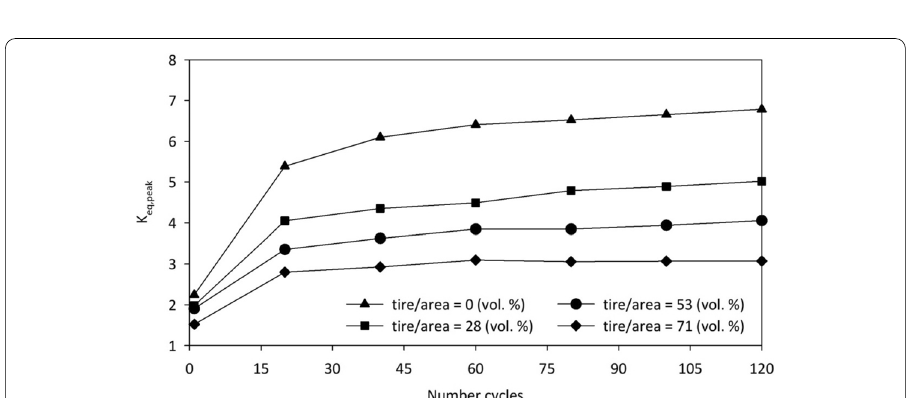
Fig. 15 Variation of K eq,peak with cycles during